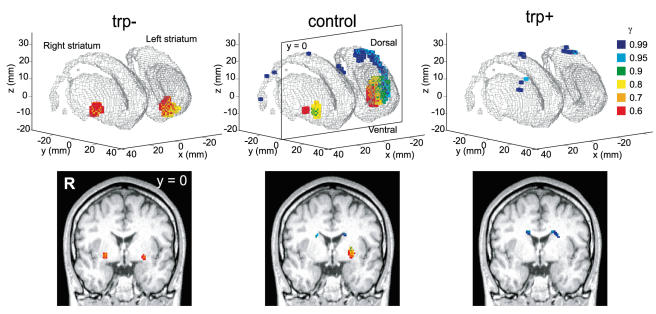
Regression analysis of BOLD signal by expected future reward with different discount rates.Voxels within the striatum (3D mesh surface) showing a significant correlation (P<0.001 in one sample t-test, uncorrected for multiple comparisons, n = 12 subjects) with V(t) at different settings of γ are shown with color codes (red: γ = 0.6, orange: 0.7, yellow: 0.8, green: 0.9, cyan: 0.95, blue: 0.99). Red to yellow coded voxels, correlated with reward prediction at shorter time scales, are predominantly located in the ventral part of the striatum (ventral putamen and nucleus accumbens), while the green to blue coded voxels, correlated with reward prediction at longer time scales, are located in the dorsal part of the striatum (dorsal putamen and caudate body).